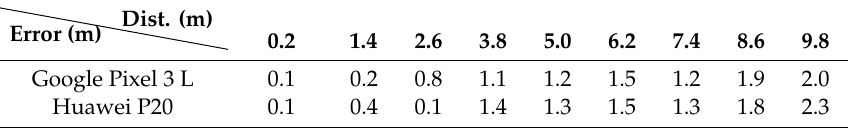
Table 3. The mean distance error with increasing distance for di ff erent phones.